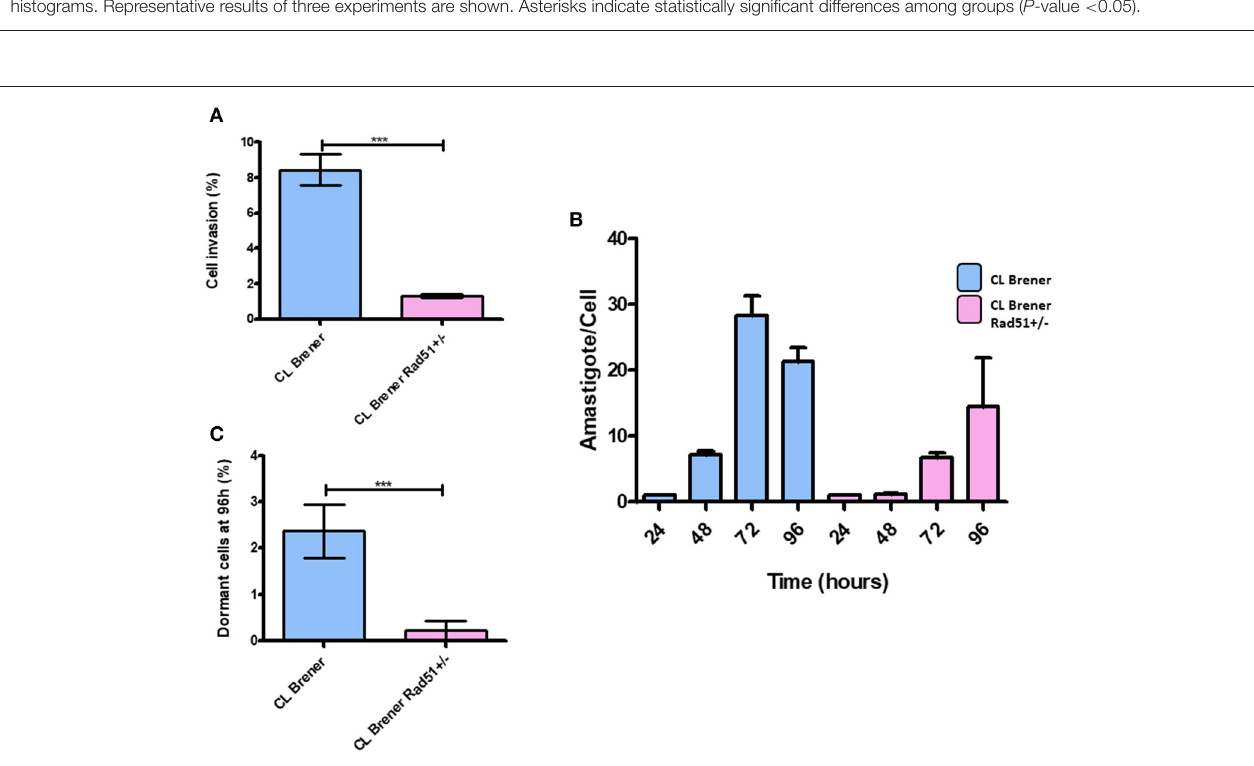
FIGURE 8 | Dormancy in amastigote forms of T. cruzi CL Brener Rad51 + / − . (A) The graph shows the percentage of infected cells in LLC-MK2 cultures infected by T. cruzi CL Brener Rad51 + / − mutants and WT cells. The number of 250 LLC-MK2 cells were analyzed (parasites labeled with anti- T. cruzi antibody were disregarded). Asterisk indicate statistically significant differences between strains ( P -value < 0.05). (B) The graph shows the rate of intracellular parasitic replication in LLC-MK2 cultures exposed to T. cruzi CL Brener Rad51 + / − mutants and WT cells during 96h of parasite exposure. A total of 100 infected LLC-MK2 cells were analyzed at each time point. (C) Percentage of intracellular parasites from T. cruzi CL Brener Rad51 + / − mutants and WT cells showing high CFSE labeling 96h post-infection. One hundred infected LLC-MK2 cells were analyzed, and the percentage of CFSE-positive ones in relation to the total number of intracellular parasites was determined.